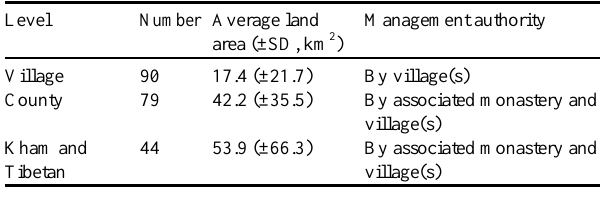
Table 1. Number, average land area, and management authority of surveyed sacred mountains of